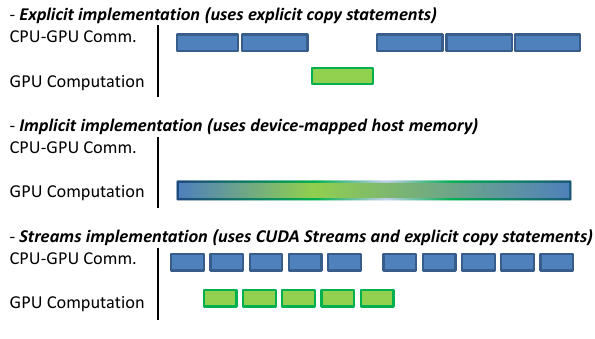
Fig. 8. Schematic of the three different implementations – Explicit , Fig.8. Schematicofthethreedifferentimplementations, Explicit , Implicit ,and Streams ,thatshowsthepotential